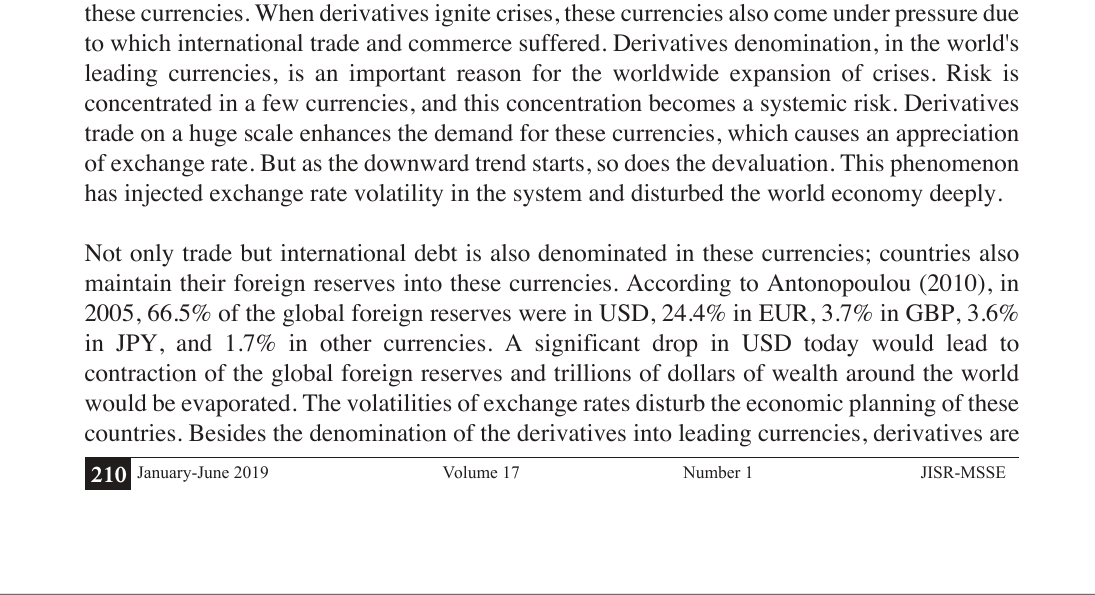
Data retrieved from finance.yahoo.com on 25th March